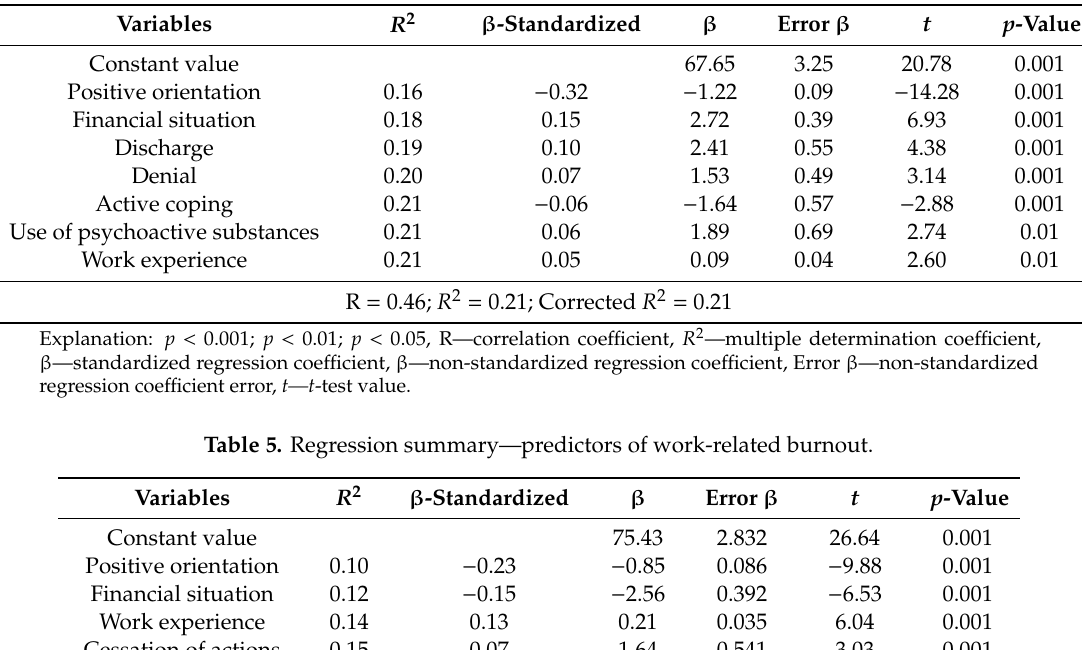
Table 4. Regression summary—personal burnout predictors.